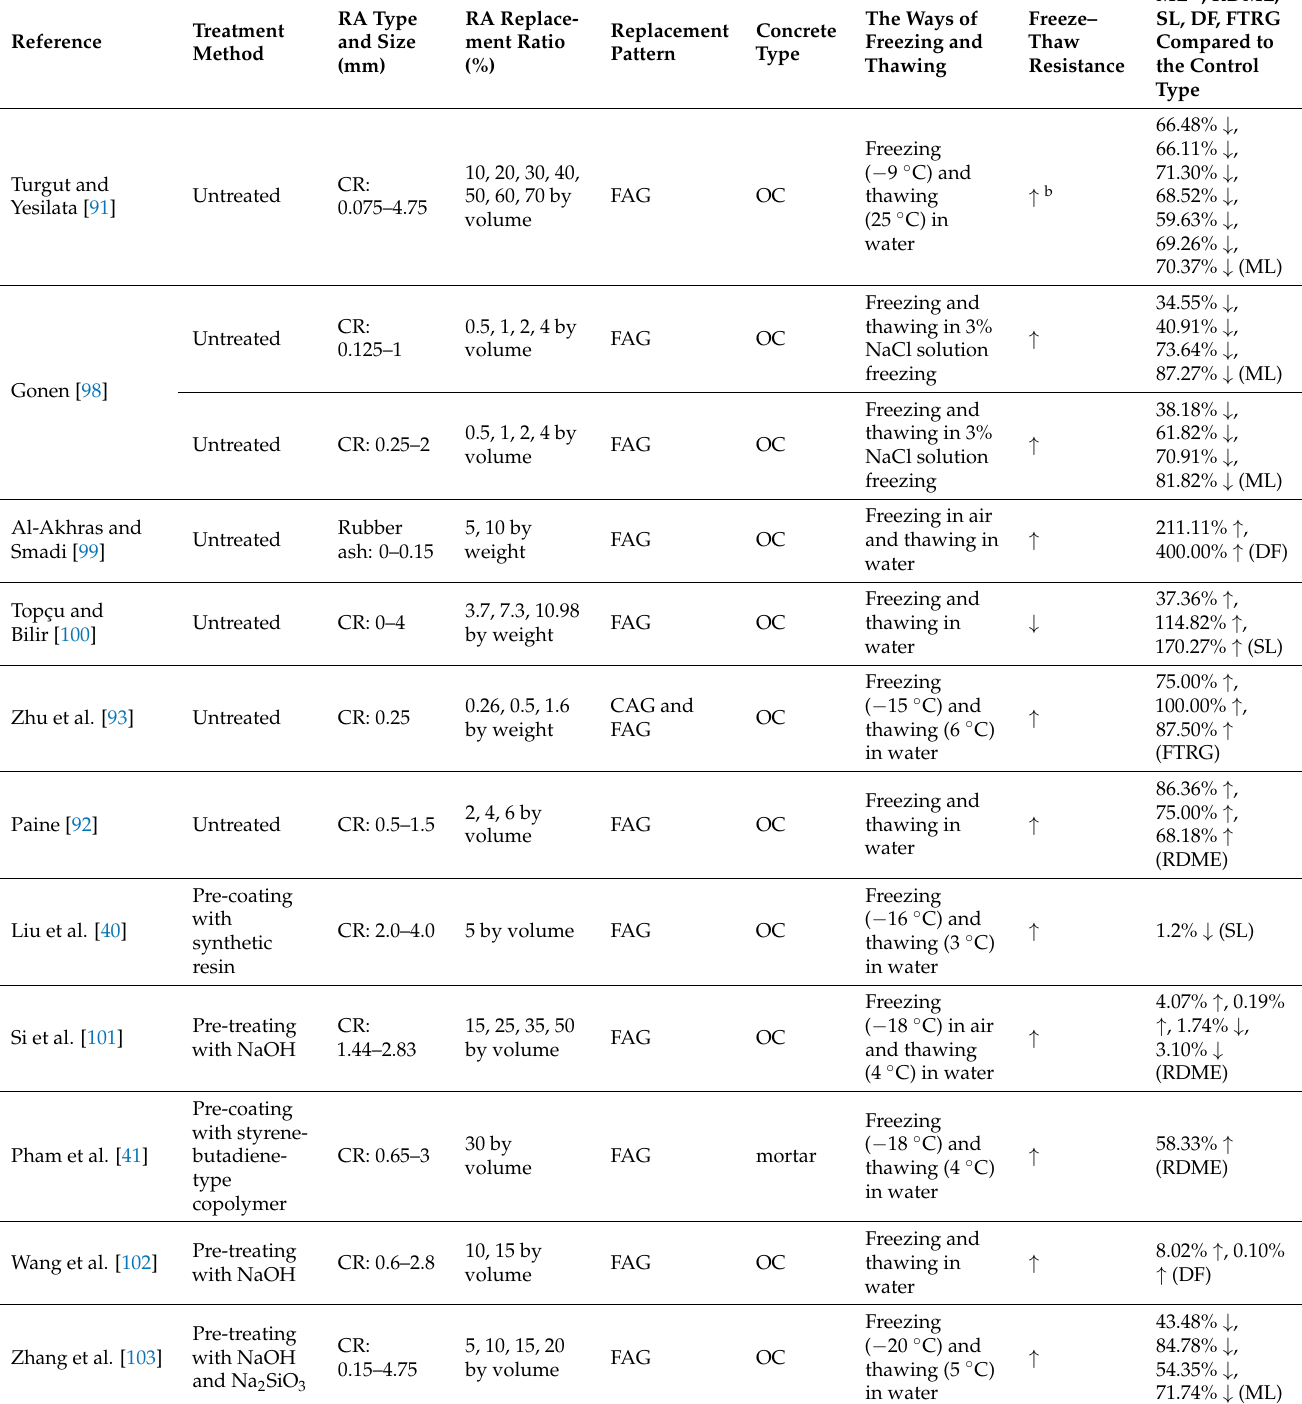
Table 8. Influence of rubber on the concrete freeze–thaw